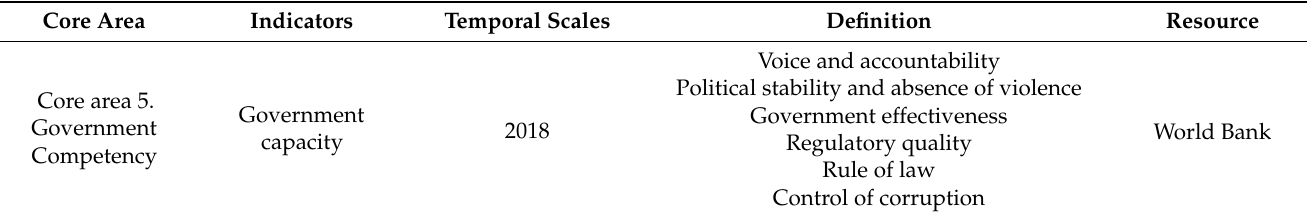
Table 5. Core area 5: indicators and variables of government competency.